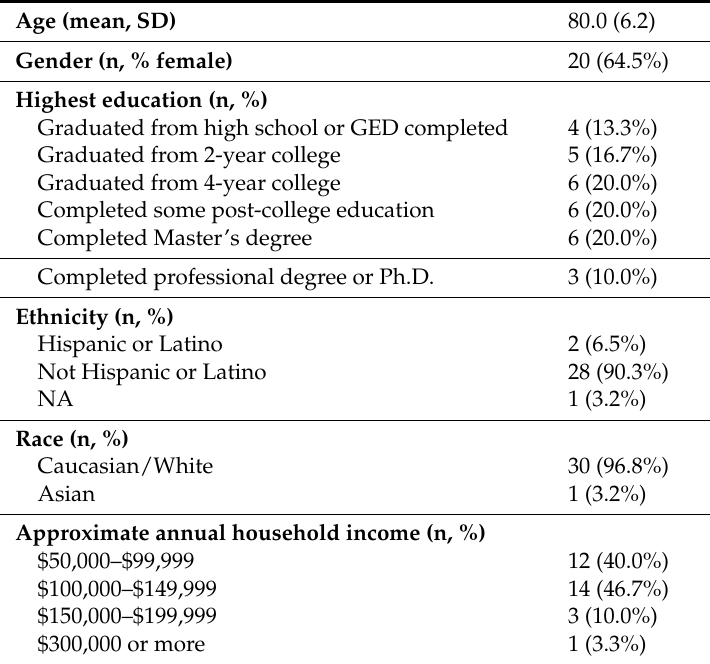
Table 1. Demographics of the